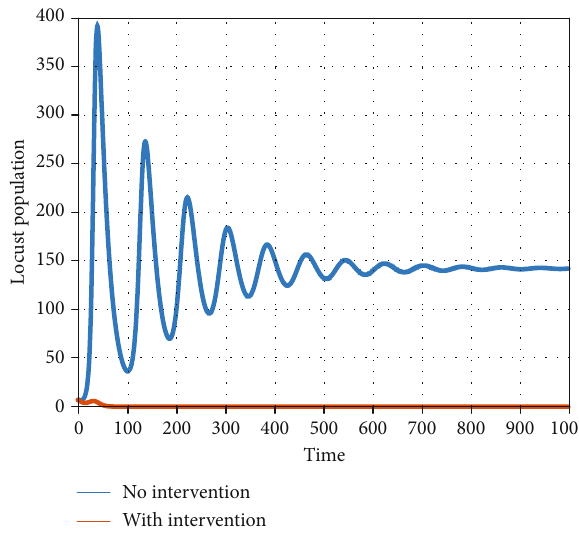
Figure 2: Evaluate the e ff ect of desert locust consumption rate by varying β value.